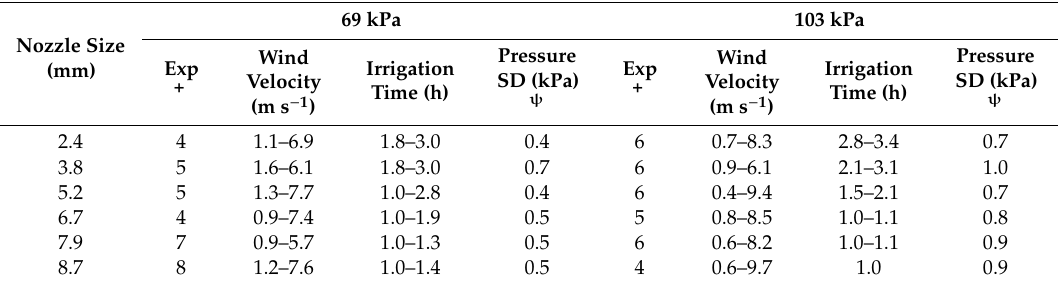
Table 1. Experimental features of the measurements of the isolated Nutator